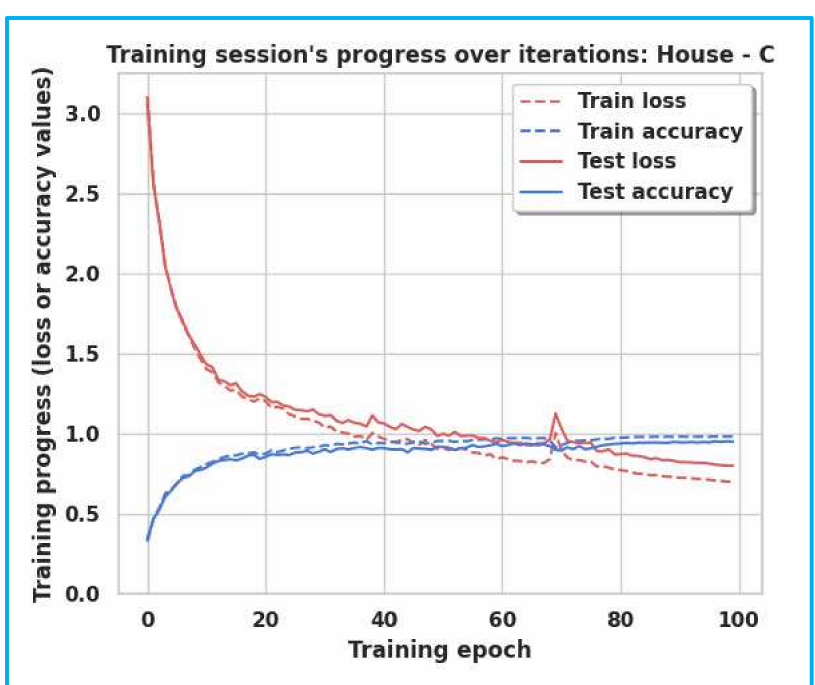
Figure 6. Training/Test Accuracy/Loss for